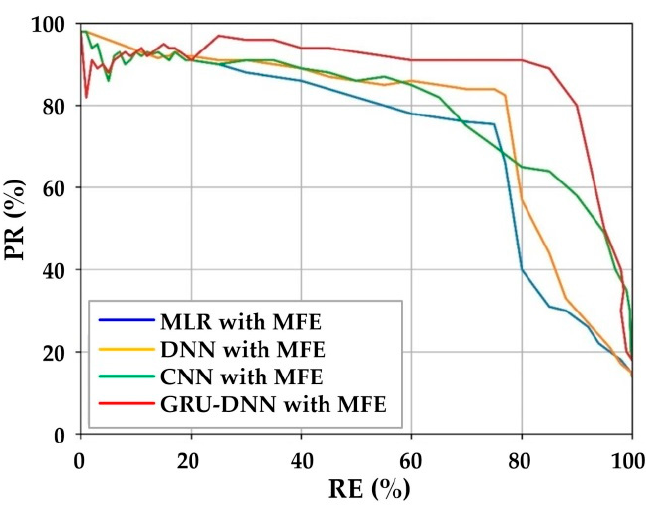
Figure 12. P-R curves of four models.